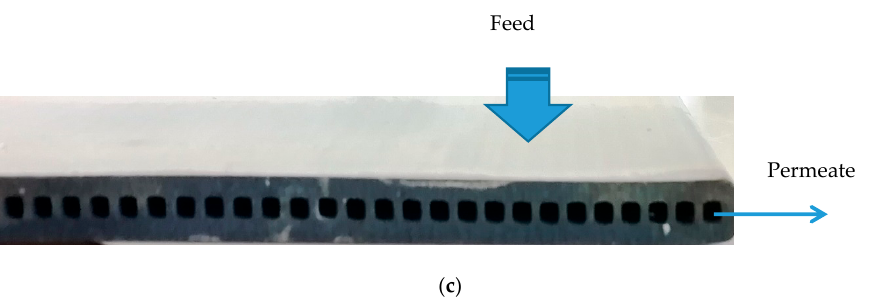
Figure 6. Submerged membrane photocatalytic reactor ( a , b ) and photocatalytic membrane ( c ), developed and tested to treat olive mill wastewaters.